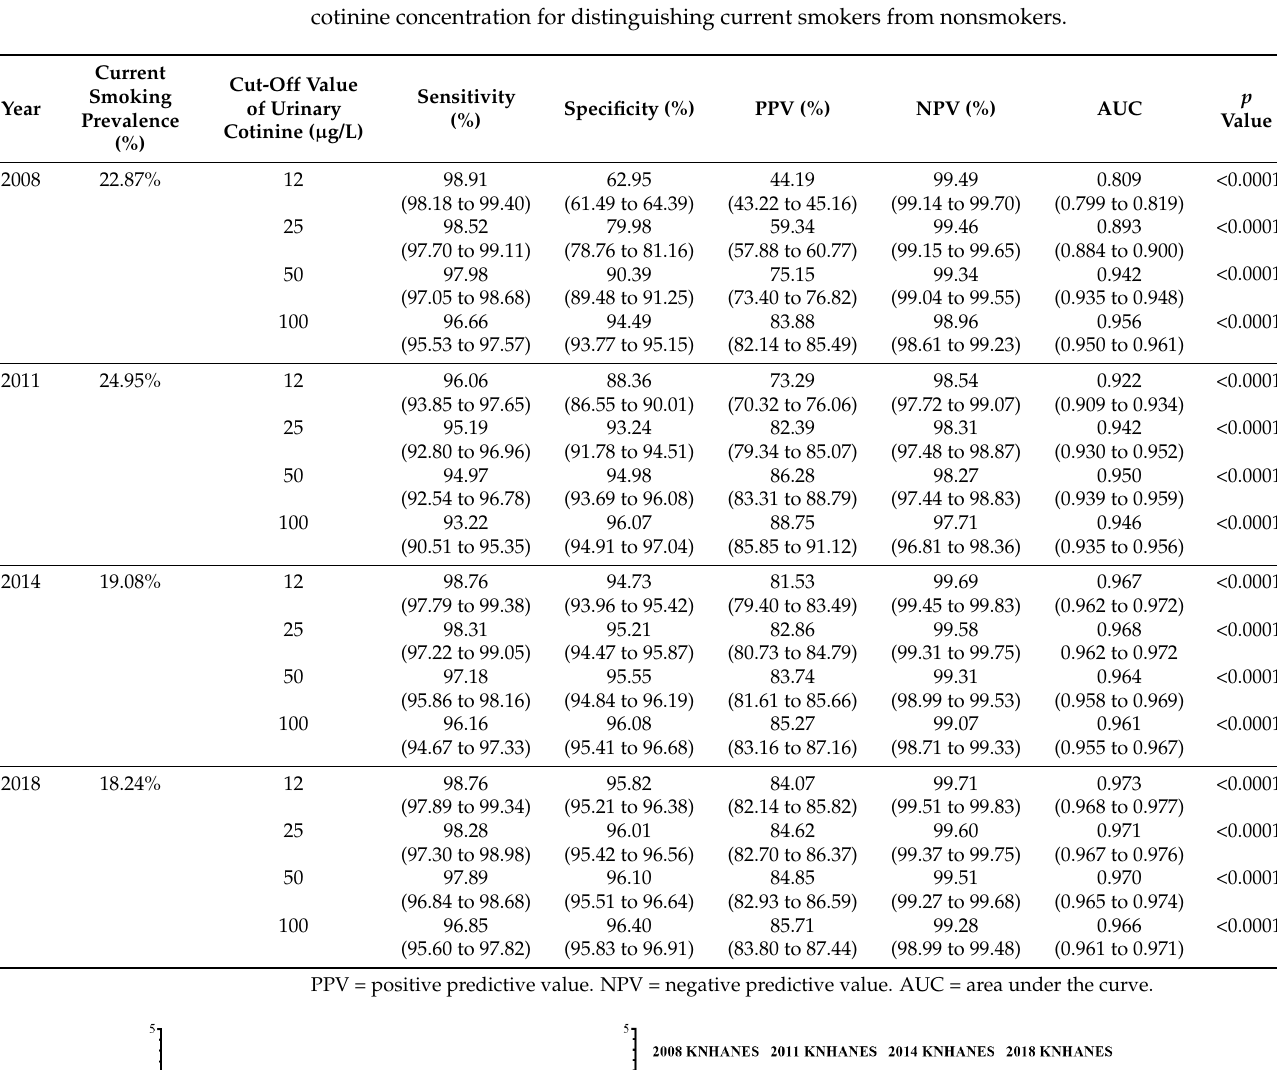
Table 6. The comparison of diagnostic performance according to various cut-off values of urinary cotinine concentration for distinguishing current smokers from nonsmokers.